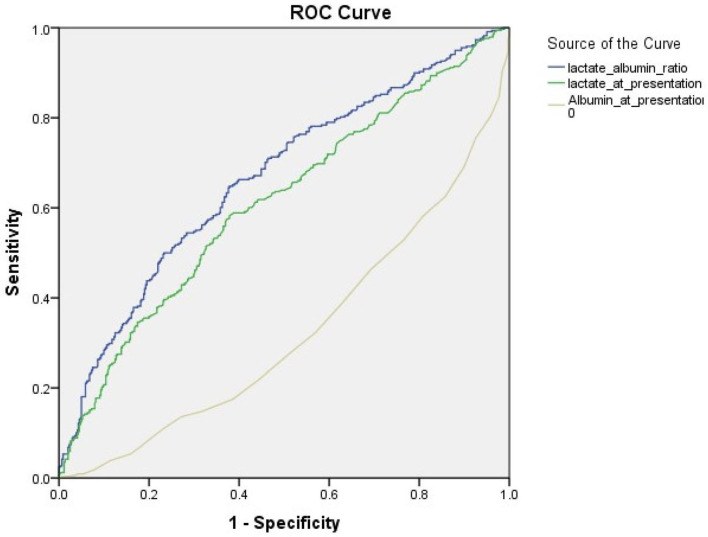
Receiver operating characteristic curves for in-hospital mortality among all septic patients. The area under the receive operating curve (AUC) for in-hospital mortality among all septic patients. The AUC for lactate is 0.61 (95% CI 0.57–0.65) and that for the lactate/albumin ratio is 0.67 (95% CI 0.63–0.70, p < 0.001).